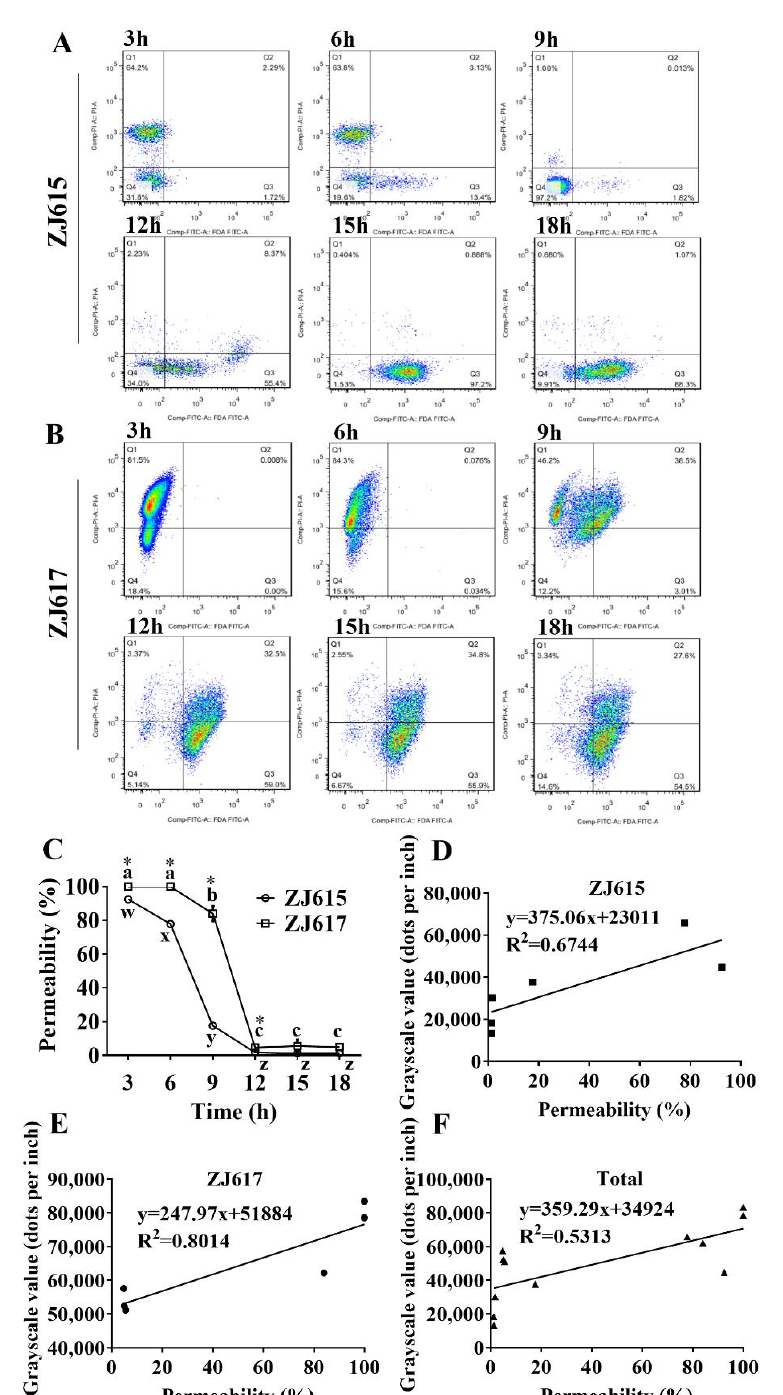
Figure 2. Cell membrane permeability of L. reuteri ZJ617 and ZJ615. ( A , B ) Bacteria were cultured in MRS at 37 ◦ C for up to 18 h and separately stained with fluorescein diacetate (FDA) or propidium iodide (PI). Flow cytometry plots are shown for L. reuteri ZJ615 ( A ) and ZJ617 ( B ). ( C ) Cell membrane permeability of L. reuteri ZJ615 and ZJ617 cultured for 3, 6, 9, 12, 15, and 18 h. ( D – F ) Correlations between the amount of cw-GAPDH and the cell membrane permeability of L. reuteri ZJ615 ( D ), ZJ617 ( E ), and both strains together ( F ) ( n = 5). A one-way ANOVA with Duncan’s multiple range test was used. Di ff erent letters indicate significant di ff erences within each strain ( p < 0.05). Asterisks indicate significant di ff erences between the two strains ( p <